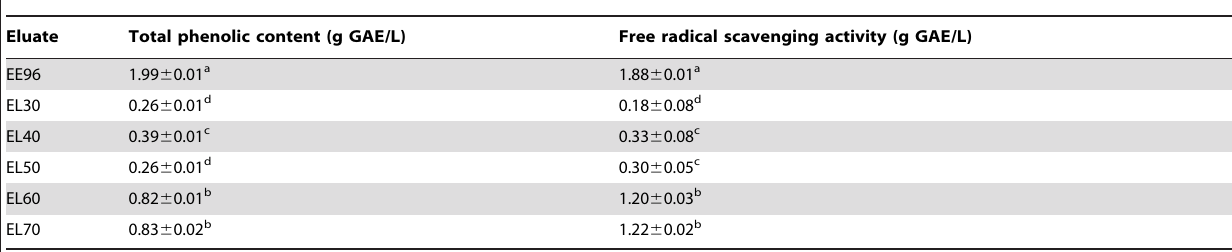
Table 1. Total phenolic content and evaluation of the free radical scavenging activity of EE96 and eluates EL30–EL70.